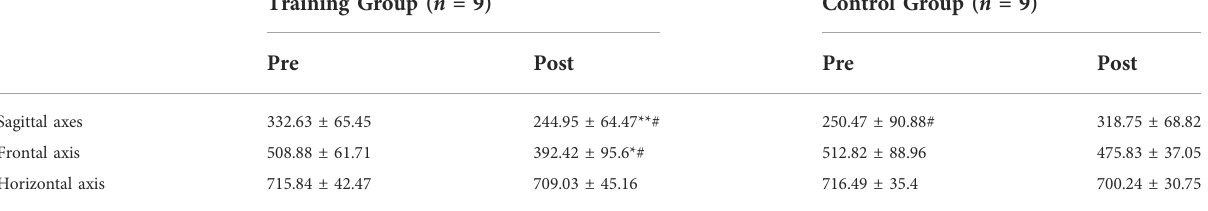
TABLE 6 Pressure center parameters (mm).